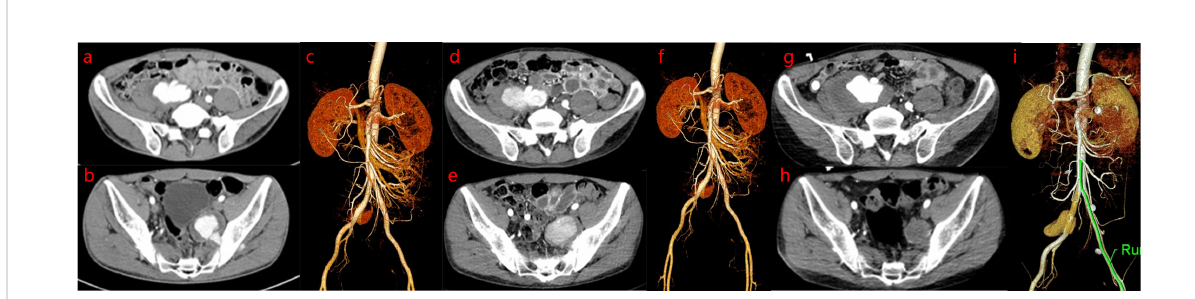
FIGURE 2 Abdominal computed tomography angiography (CTA) examination. Abdominal CTA images show dynamic progression of pseudoaneurysm based on drug intervention before bare stent implantation: the area of pseudoaneurysm of the right CIA is larger, while the area of the pseudoaneurysm of the left IIA is smaller. (A-C) . On admission abdominal CTA revealed rupture of the right common iliac artery (CIA) and left internal iliac artery (IIA), which was complicated by the formation of a pseudoaneurysm. (D – F) . After 1 month of drug therapy, abdominal CTA revealed that the area of the pseudoaneurysm of the right CIA was larger than that at the fi rst examination, while the area of the pseudoaneurysm of the left IIA was similar to that at the fi rst examination. (G – I) . After 10 months of drug therapy, abdominal CTA revealed that the area of pseudoaneurysm of the right CIA was larger than that at the second examination, while the area of pseudoaneurysm of the left IIA was smaller than that at the second